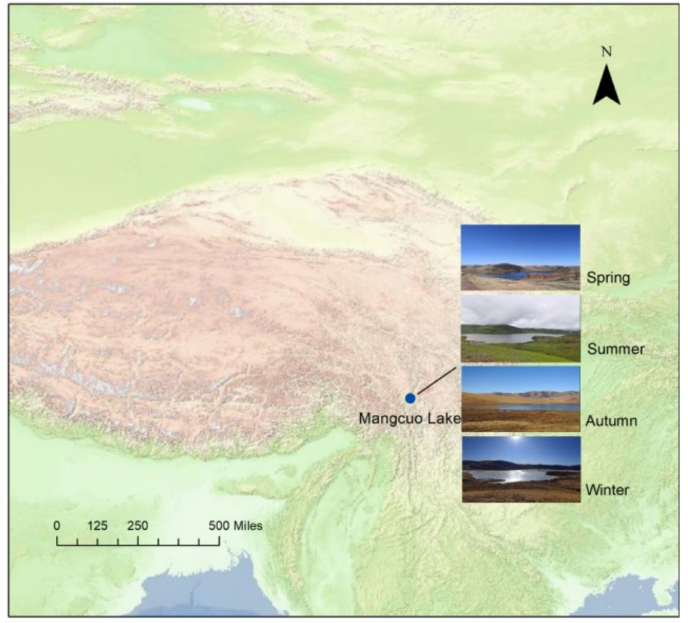
Figure 1. The location of Mangcuo Lake and the real view of the four seasons. Mangcuo Lake is a typical highland wetland ecosystem; the vegetation is dominated by an alpine subarctic shrub meadow. The meadow vegetation includes Kobresia pyg- maea, Polygonum macrophyllum, and Blysmus sinocompressus; the aquatic vegetation is Potamogeton pectinatus of the family Potamogetonaceae; and the marsh vegetation is Triglochin maritimum and Hippuris vulgaris. It provides food and habitats for birds and other highland wildlife. The surveys were conducted in two representative habitats in the lake area: a relatively complex marsh wetland consisting of a transition zone of herbaceous marshes and large lakes, and a relatively homogeneous lake habitat dominated by highland freshwater